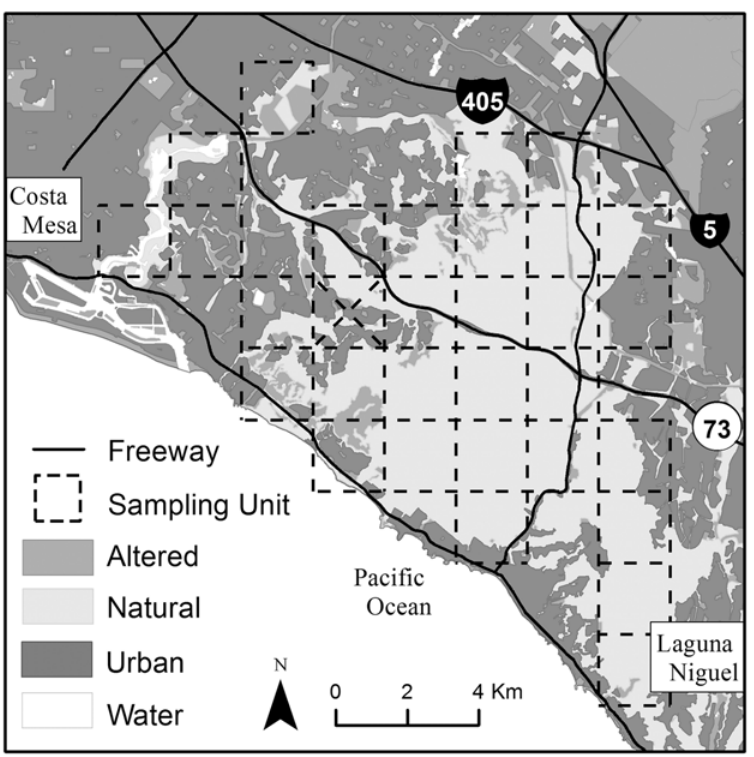
Fig 1. The San Joaquin Hills study area, Orange County, California. The sampling unit grid (dashed lines) was used to determine the locations of remote camera stations. Map figure base layers from SCAG [35] and StreetMap USA for ESRI ArcGIS 9.3, for representational purposes